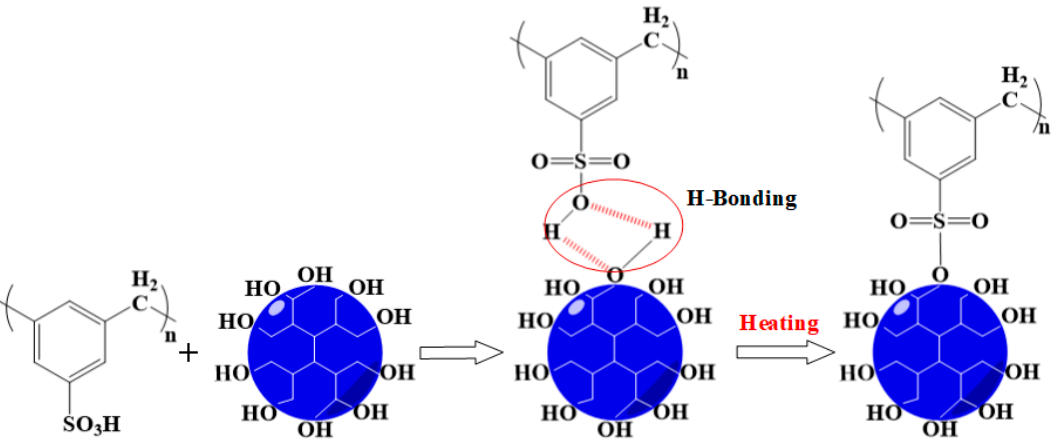
Figure 3. Mechanism of thermal crosslinking.